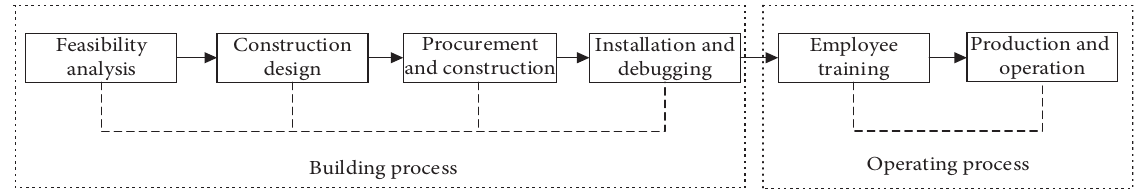
Figure 1: Building and operating process of mine